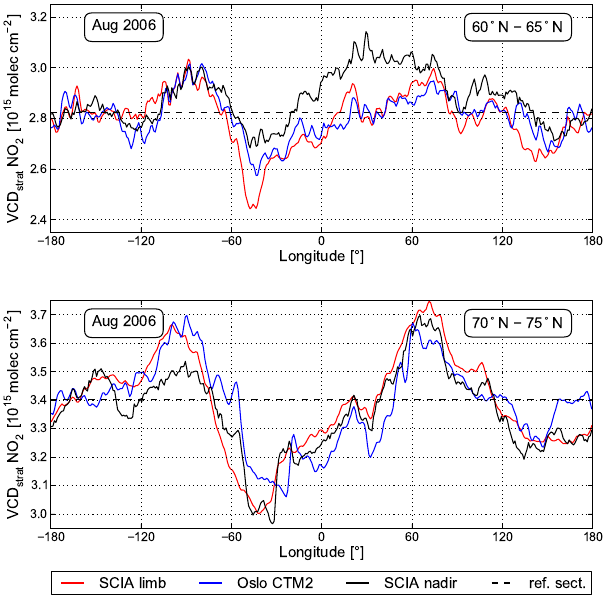
Fig. 10. Zonal variation of VCD 0 limb strat , VCD 0 mod strat , and VCD 0 nadir strat . The nadir measurements’ value over the reference sector is marked as dashed black line. Monthly mean values for August 2006, be- tween 60 ◦ and 65 ◦ N (top) and between 70 ◦ and 75 ◦ N (bottom).